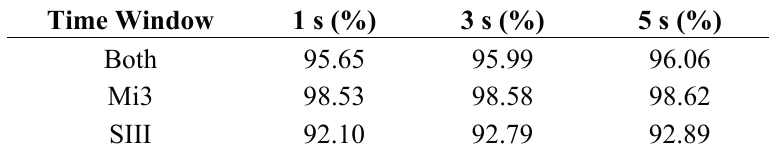
Table 5. Results of the floor positioning with different time windows and